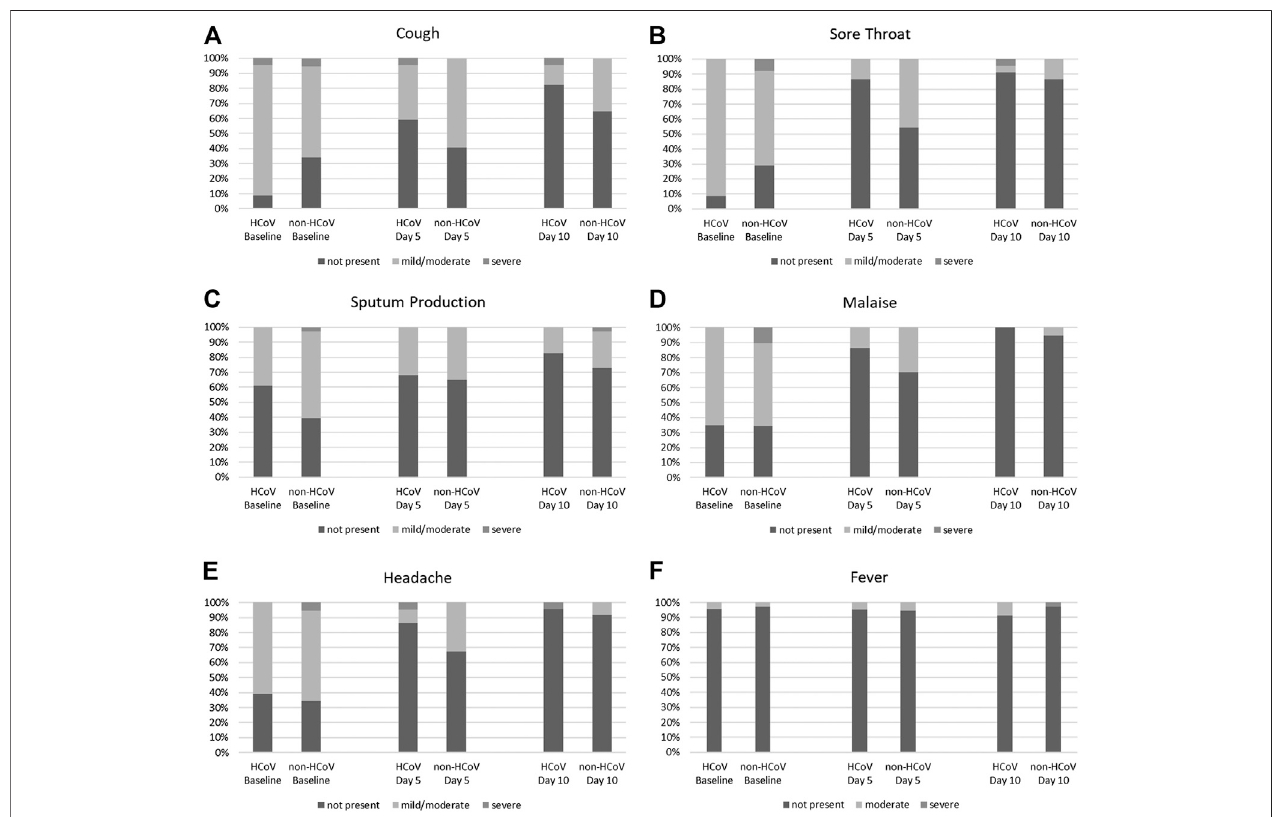
FIGURE2| Symptomseverityof (A) cough, (B) sorethroat, (C) sputumproduction, (D) malaise, (E) headache,and (F) feverintheHCoVandnon-HCoVsubsetsat baseline, day 5 and day 10 of the trial (% of patients).